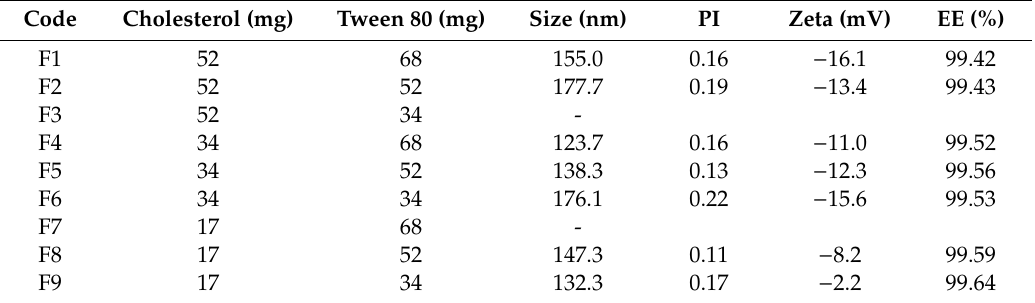
Table 13. Composition and physical characteristics of the naringenin-loaded elastic liposomes. Code